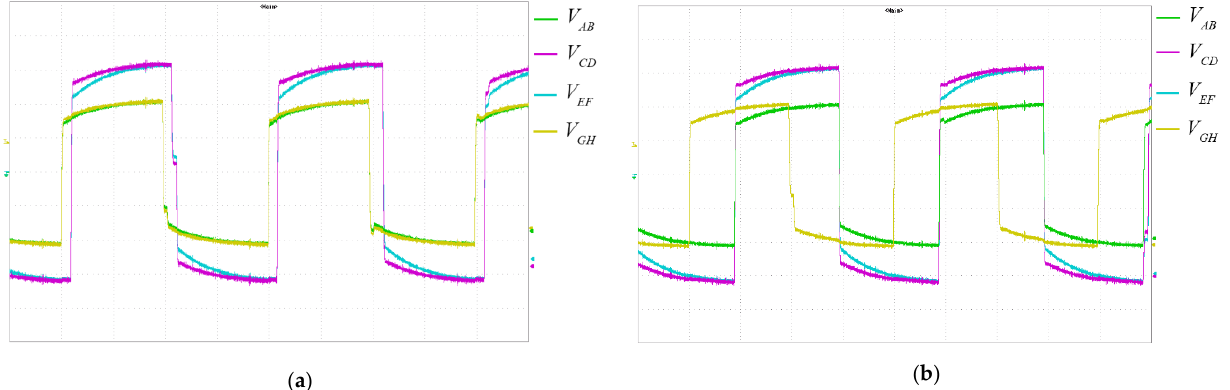
Figure 14. Voltage waveforms with the SPS modulation technique at f sw = 50 kHz, V AB (green, 200 V/div), V CD (magenta, 200 A/div), V EF (cyan, 200 V/div), and V GH (yellow, 200